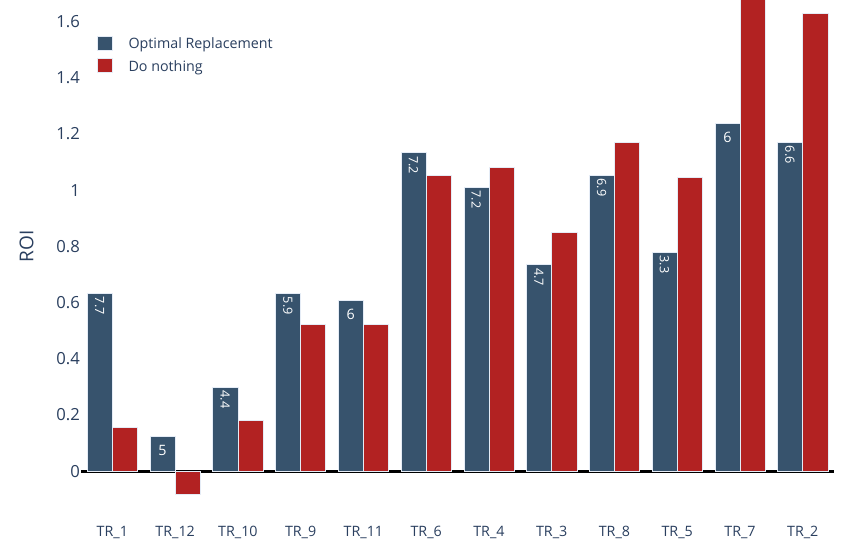
Figure 13. Ranking by higher benefit of optimal asset fleet